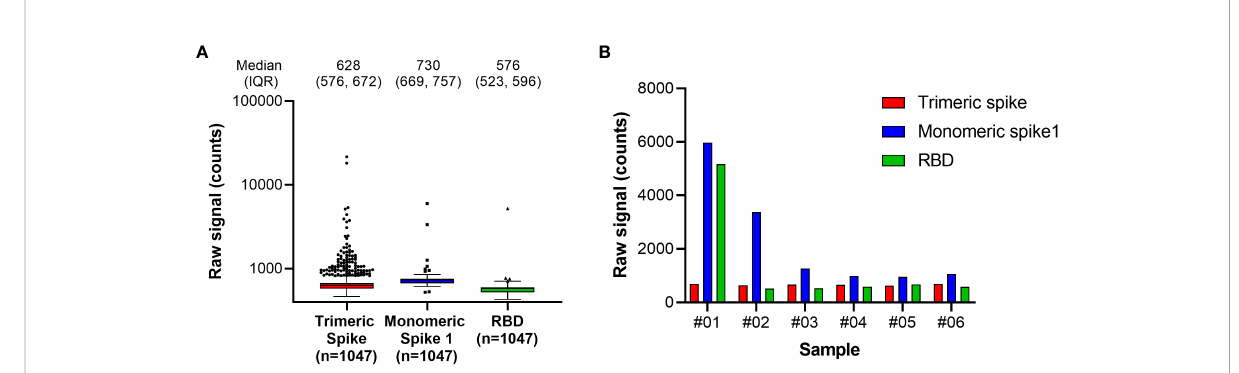
FIGURE 1 Antigen speci fi city in pre-pandemic samples. Assessment of Spike antigen speci fi city in pre-pandemic serum samples (n=1047) is shown in (A) . Samples with results exceeding the 95% con fi dence interval of signal distribution in the assessment with Monomeric Spike 1 or RBD, as shown in (A) , were resolved in detail in (B) . RBD, receptor binding